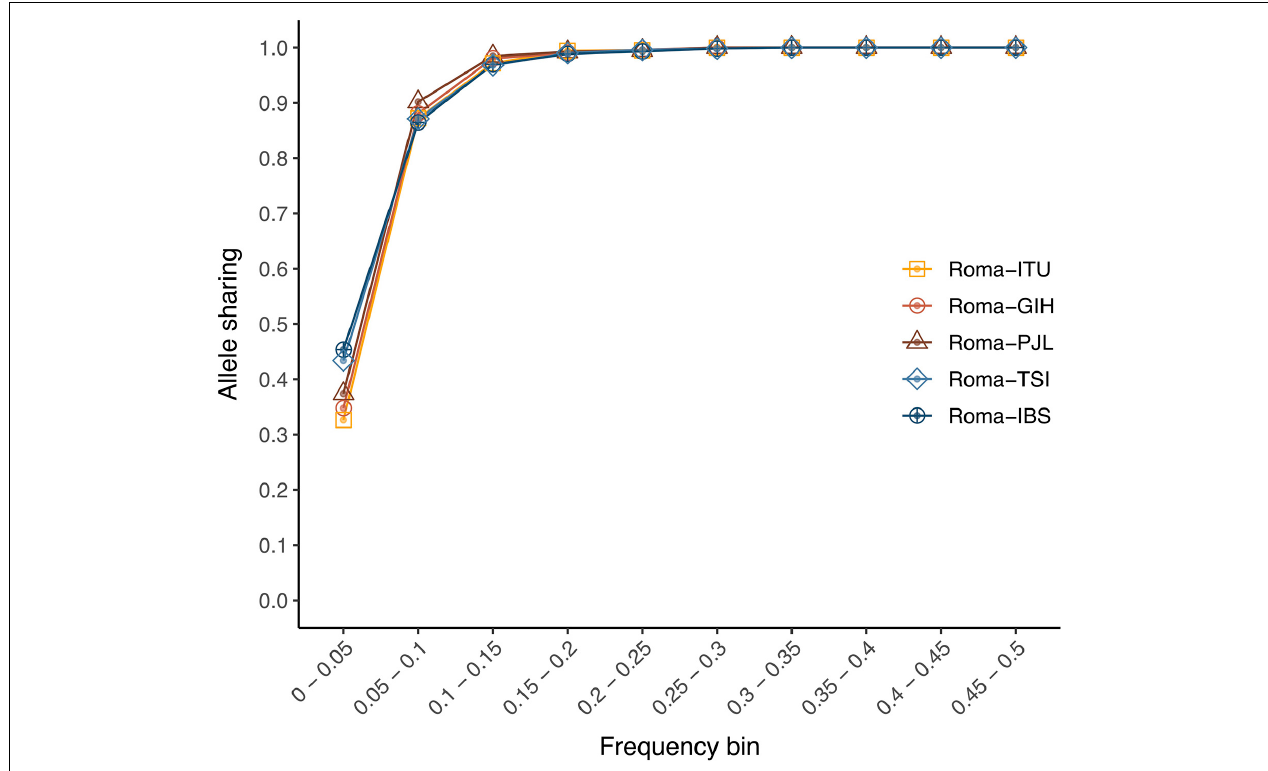
FIGURE 1 | Allele-sharing ratios among Roma and non-Roma groups. Proportion of Roma variants from each minor allele frequency bin (from > 0% to 50%) which are also segregating at each non-Roma population.